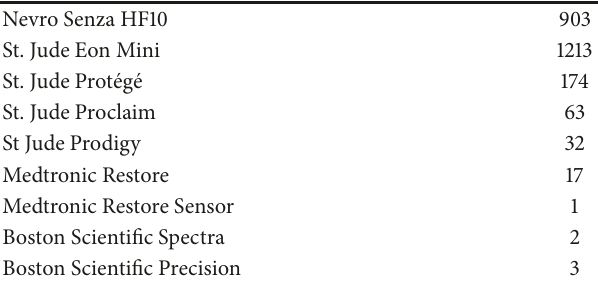
Table 2: Total number of adverse events reported to FDA MAUDE database by